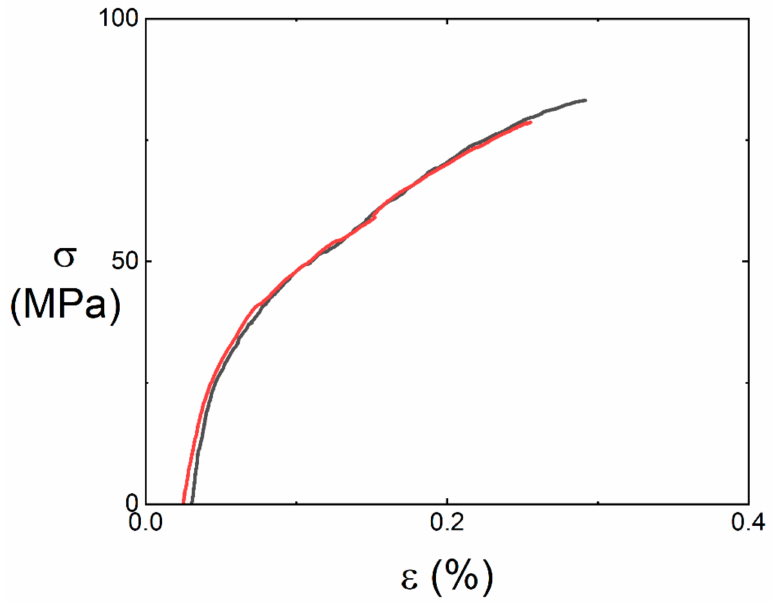
Figure 3. Monotonic tensile stress–strain curves of the 12k T-700 TM MWK–N–C/SiC